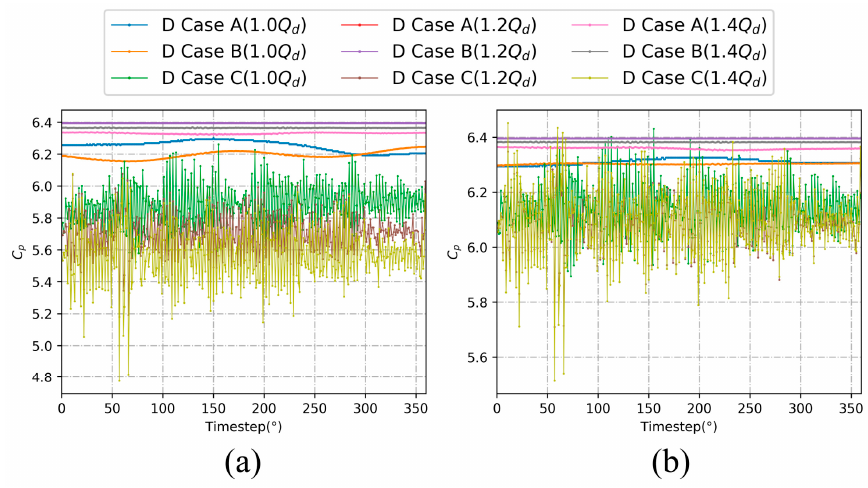
Figure 18. Time-domain of pressure fluctuations at different monitoring points within the outlet pipe of the three optimized impeller cases at the locations of: ( a ) D1 and ( b ) D2.